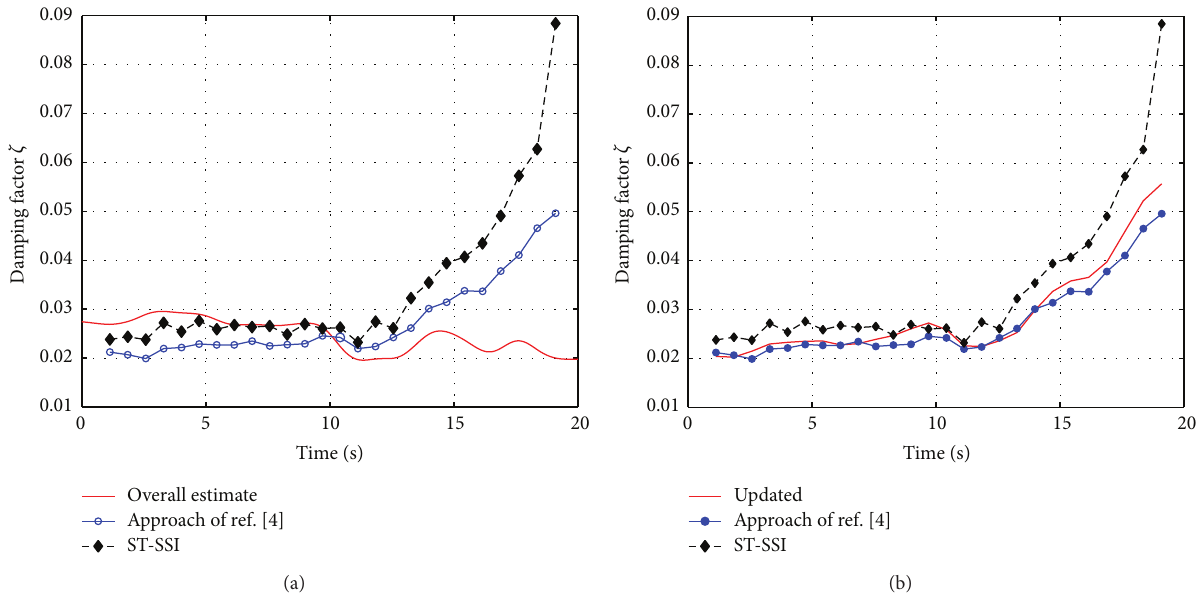
Figure 6: Moving-mass Case 1. Estimates of the damping factors, compared with the overall estimate of (3) (a) and with the updated value of (7) (b).